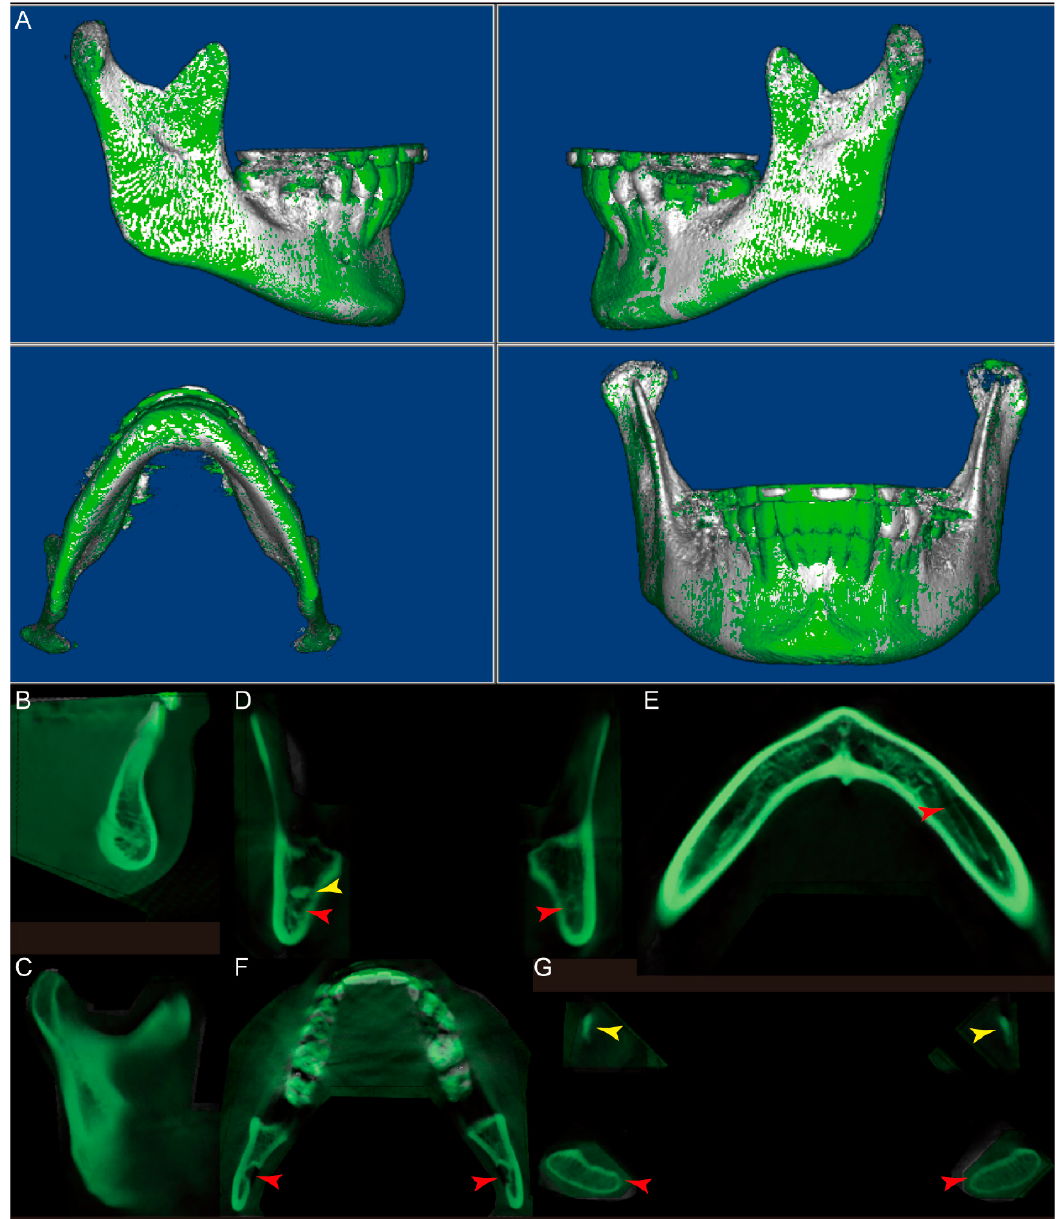
Figure 5. The Dolphin 3D voxel-based superimposition of the initial (white, CBCT #1) and final (green, CBCT #2) CBCT datasets of the mandible for patient #1. ( A ) The 3D reconstructed surface structure image of the mandible after superimposition. ( B ) Sagittal slice along the facial midline. ( C ) Sagittal slice in the left ramus region. ( D ) Coronal slice in the retromolar region. Yellow arrow: a radiopaque area on the right side of the mandible; red arrows: inferior alveolar canals. ( E ) Axial slice at the spinae mentalis level. Red arrow: left inferior alveolar canal. ( F ) Axial slice at the mandibular foramen level. Red arrows: mandibular foramen. ( G ) Axial slice at the level of the tips of the coronoid processes. Yellow arrows: coronoid process; red arrows: condyle.